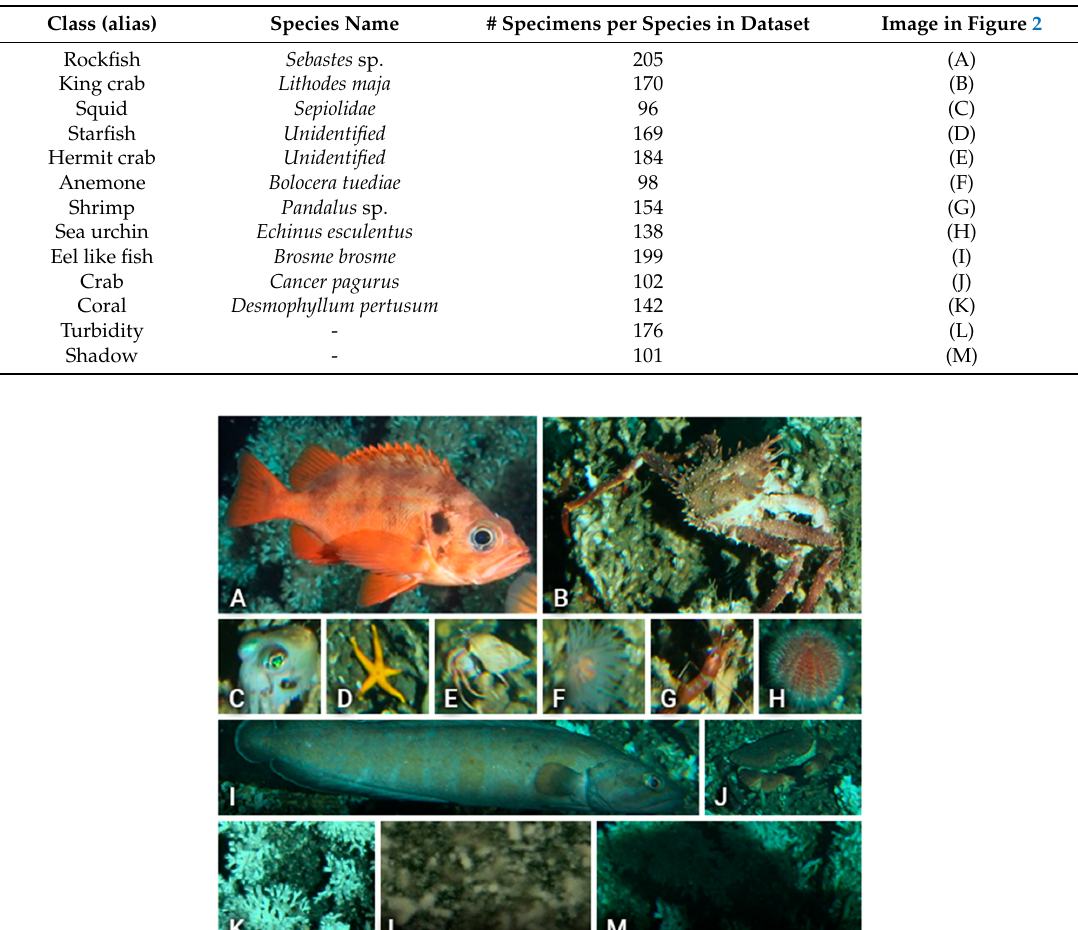
Table 1. An example of video-detected species used for building the training dataset for reference at automated classification.